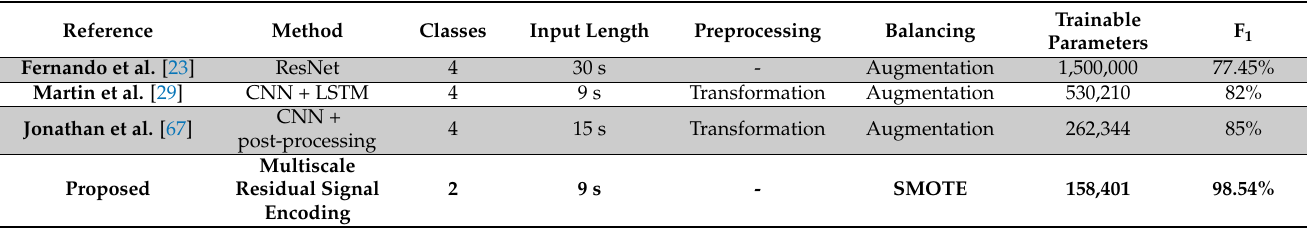
Table 14. Comparison of the results of our proposed model with those of different models in terms of trainable